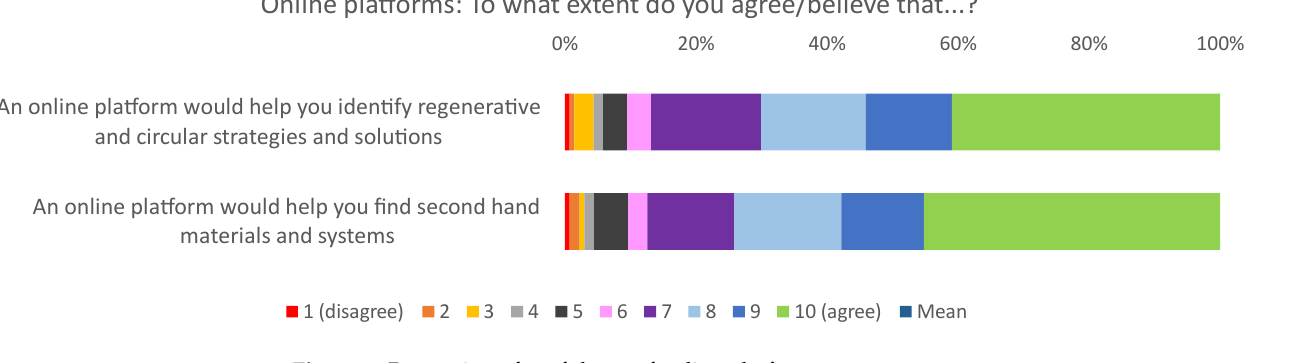
Figure 8. Perception of usefulness of online platforms.